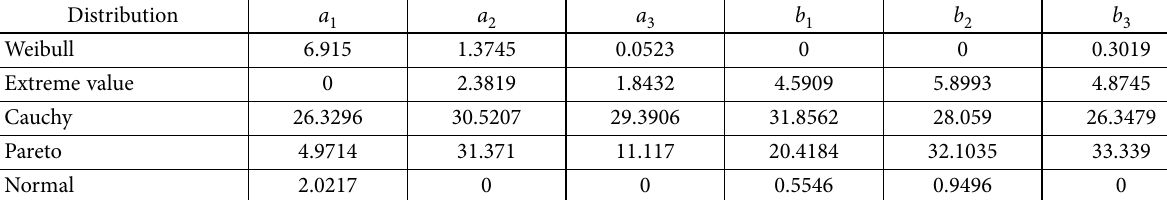
Table 13. Differences Δ between AIC values